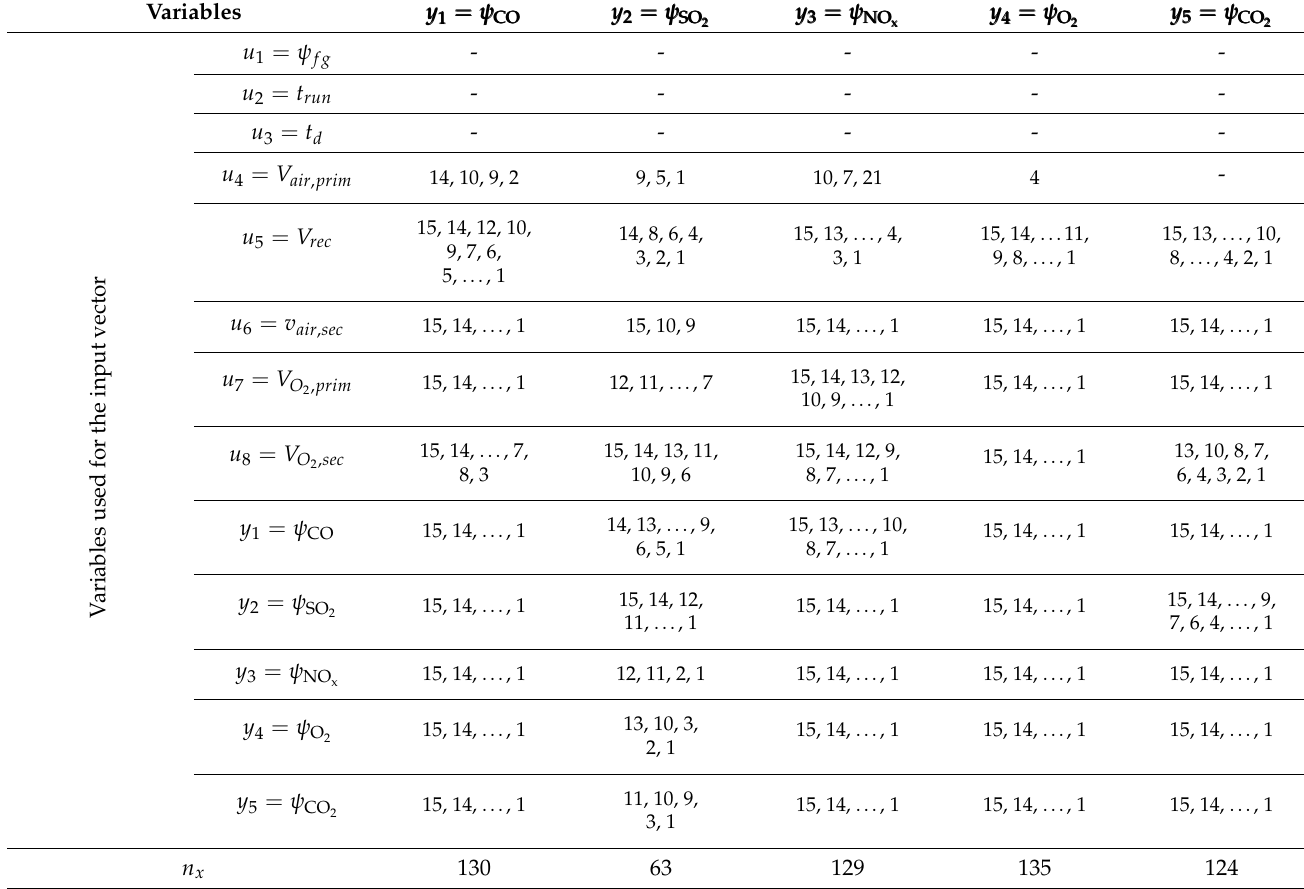
Table 6. Table of state vectors x i for outputs y i (listed in columns) proposed by Boruta Feature Selection Algorithm